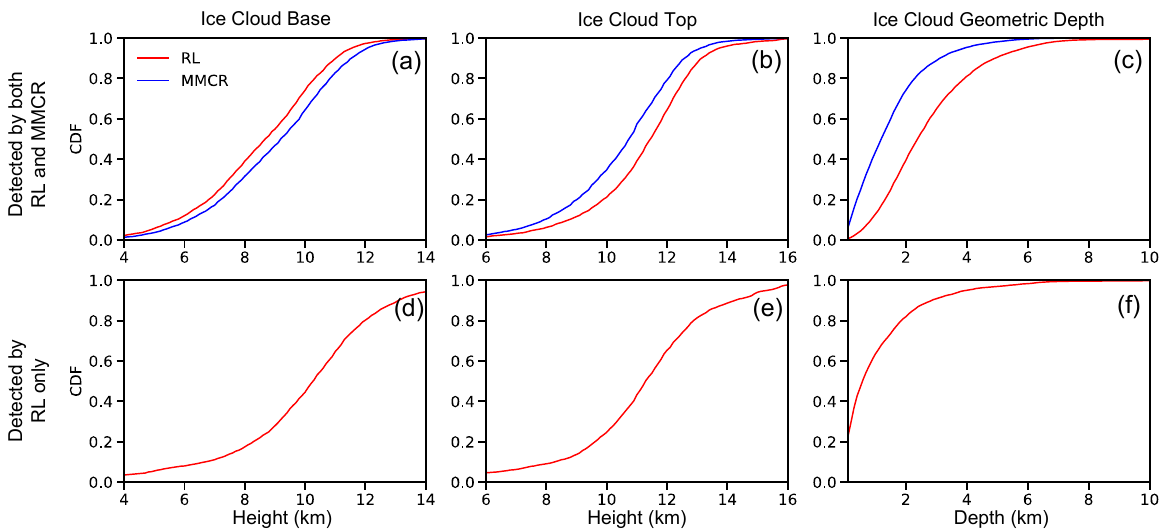
Figure 4. ( a – c ) Cumulative distribution functions (CDFs) of ice cloud base height (left), cloud top height (middle), and cloud geometric depth (right) (units: km) for transparent profiles with ice clouds only and detected by both Raman lidar (RL; red) and millimeter wavelength cloud radar (MMCR; blue) at the Southern Great Plains (SGP) site from August 2008 to January 2011. ( d – f ) CDFs for transparent profiles with ice clouds only that are detected by RL only; thus, only the RL results are shown here.